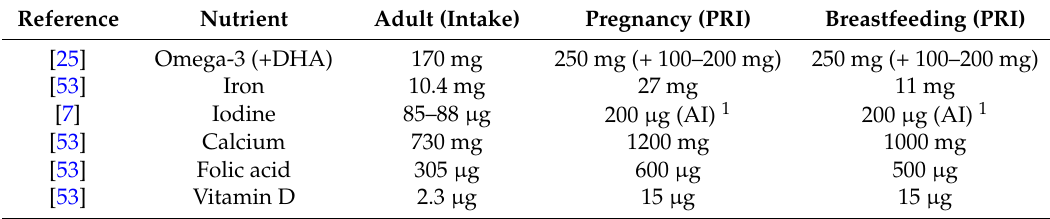
Table 4. Recorded daily intakes of selected micronutrients in the Italian adult population